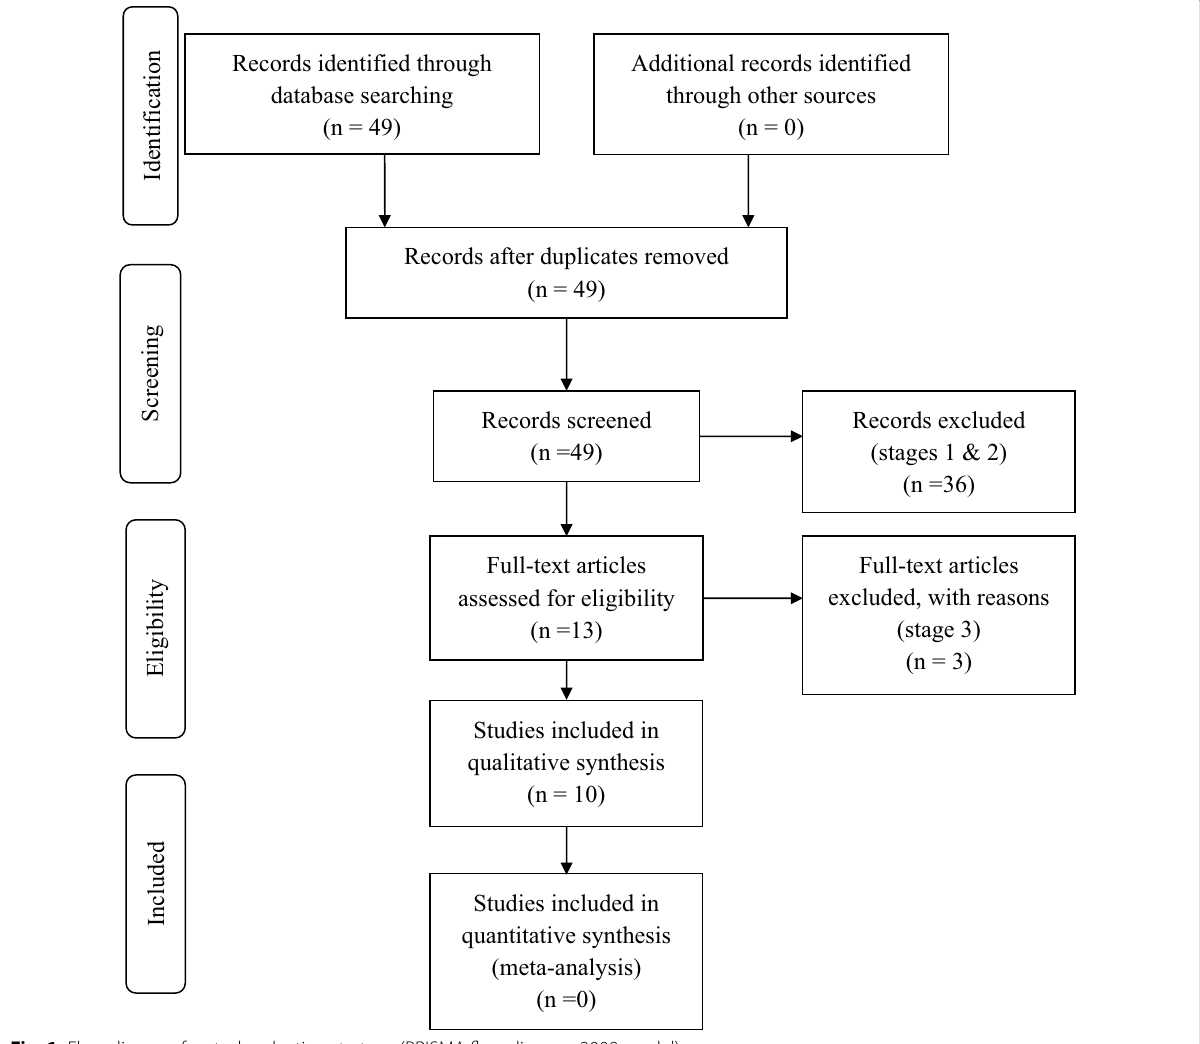
Fig. 1 Flow diagram for study selection strategy (PRISMA flow diagram 2009